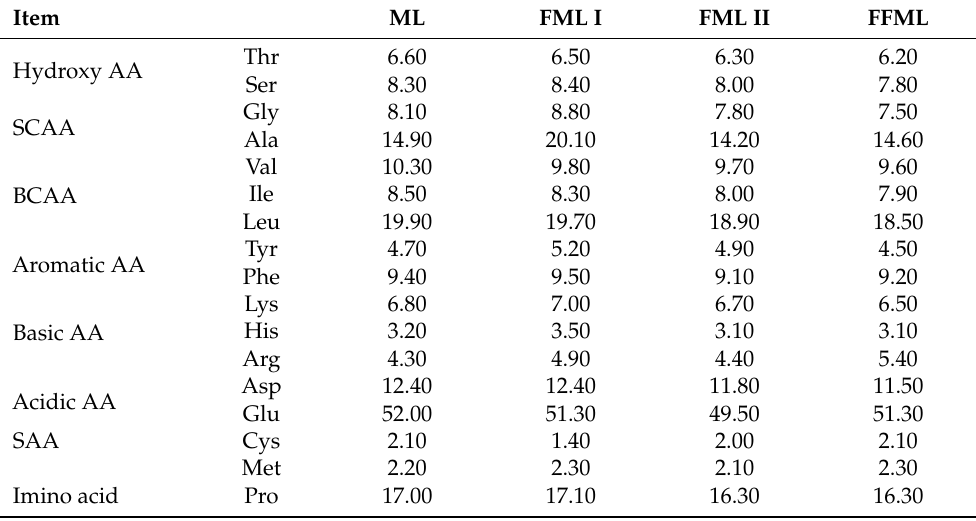
Table 2. Hydrolyzed amino acid composition of Mao-tai lees and fermented Mao-tai lees (g/kg of